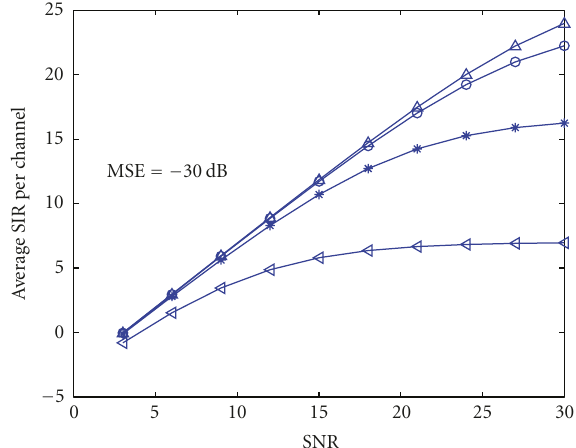
Figure 4: Plot of average SIR per channel versus SNR for MSE = − 30 dB (graphs are plotted for σ 2 = 0, (2 π/ 1000) 2 , (2 π ) 2 / 10 5 , ω (2 π/ 100) 2 from uppermost to downmost, resp.).